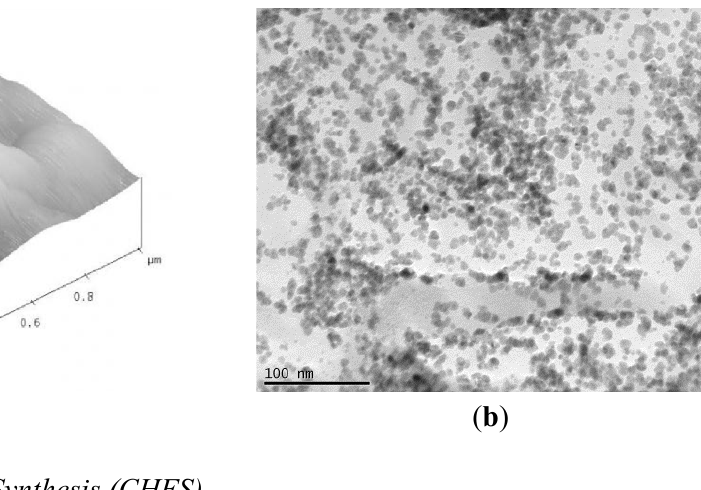
Figure 5. ( a ) Atomic force microscopy (AFM) images and ( b ) transmission electron microscopy (TEM) images of Pd-graphene